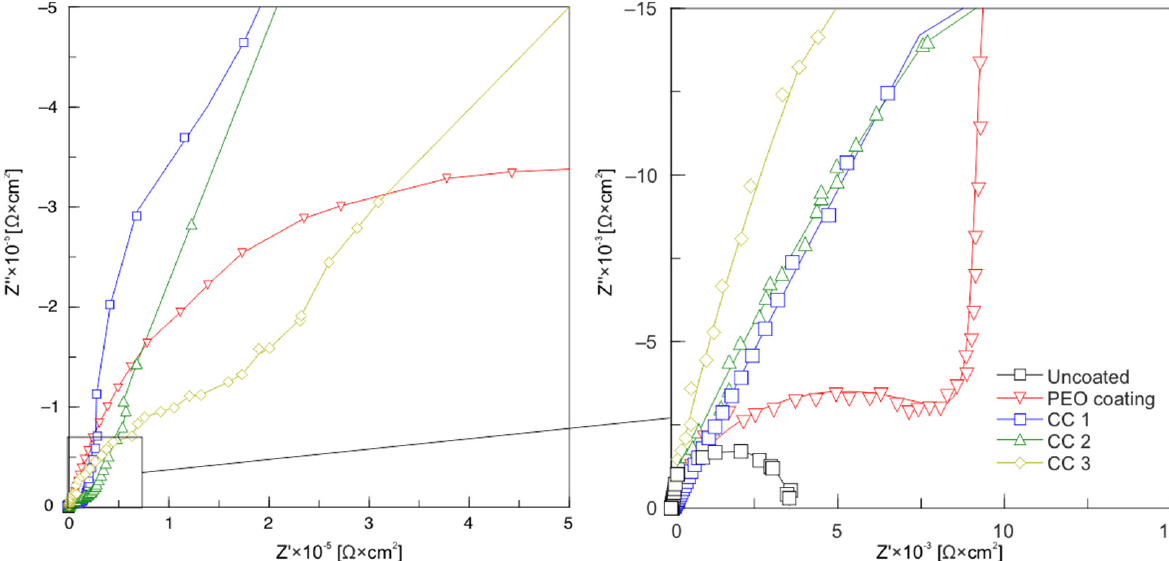
Figure 7. Nyquist plots for uncoated, PEO-coated, CC 1, CC 2, and CC 3 samples.